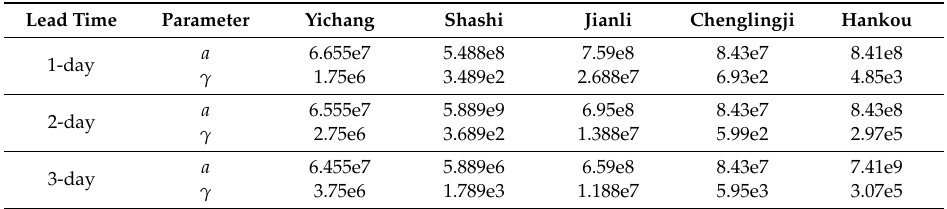
Table 1. Parameters of the LSSVM i (least squares support vector machine) model with regard to different forecast lead